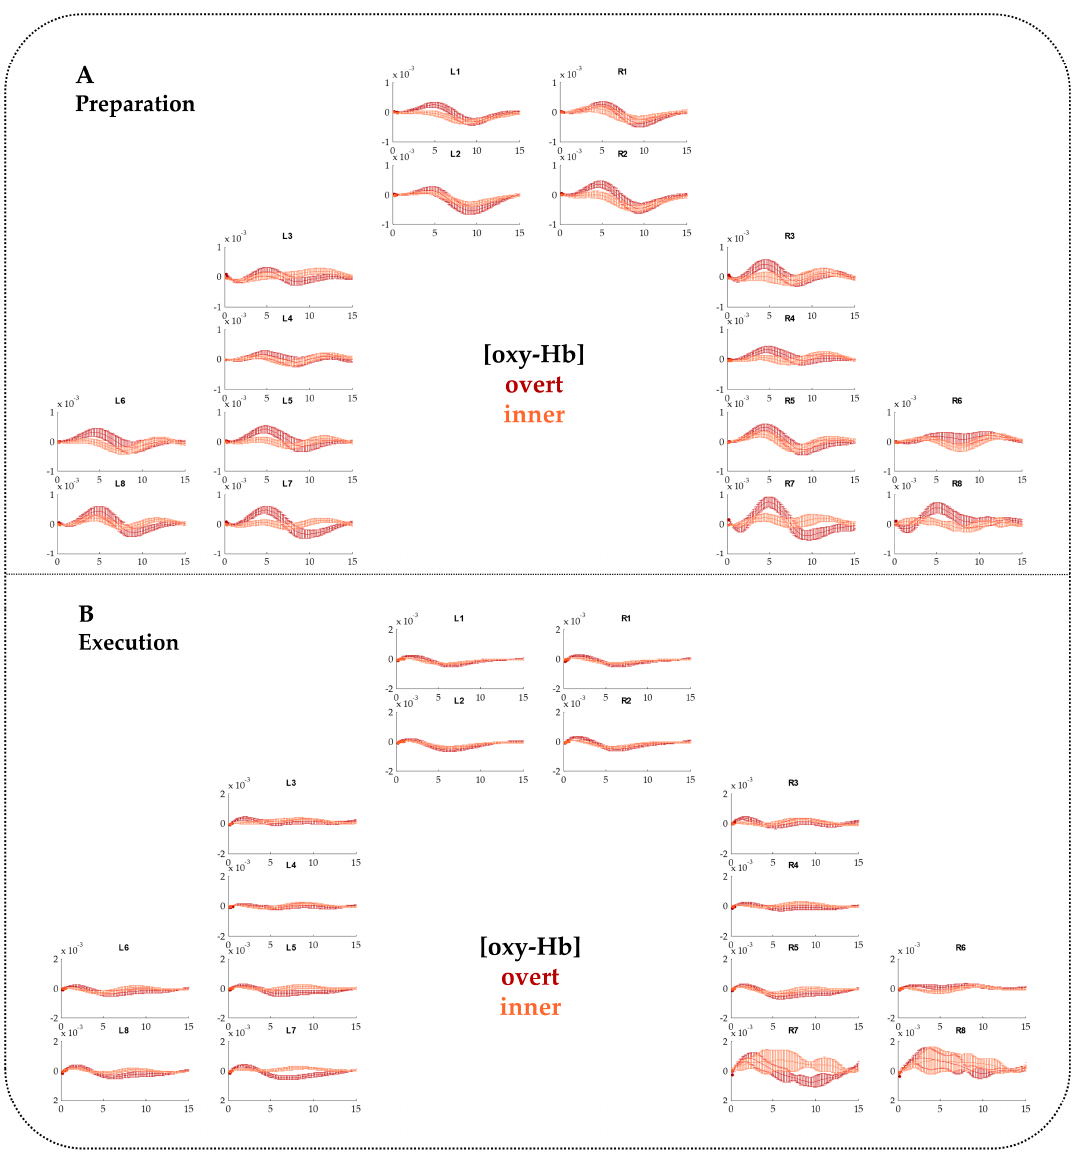
Figure A2. FNIRS time courses including standard errors of the mean (SEMs) for [oxy-Hb] contrasting overt and inner speech for the Preparation phase ( A ) and the Execution phase ( B